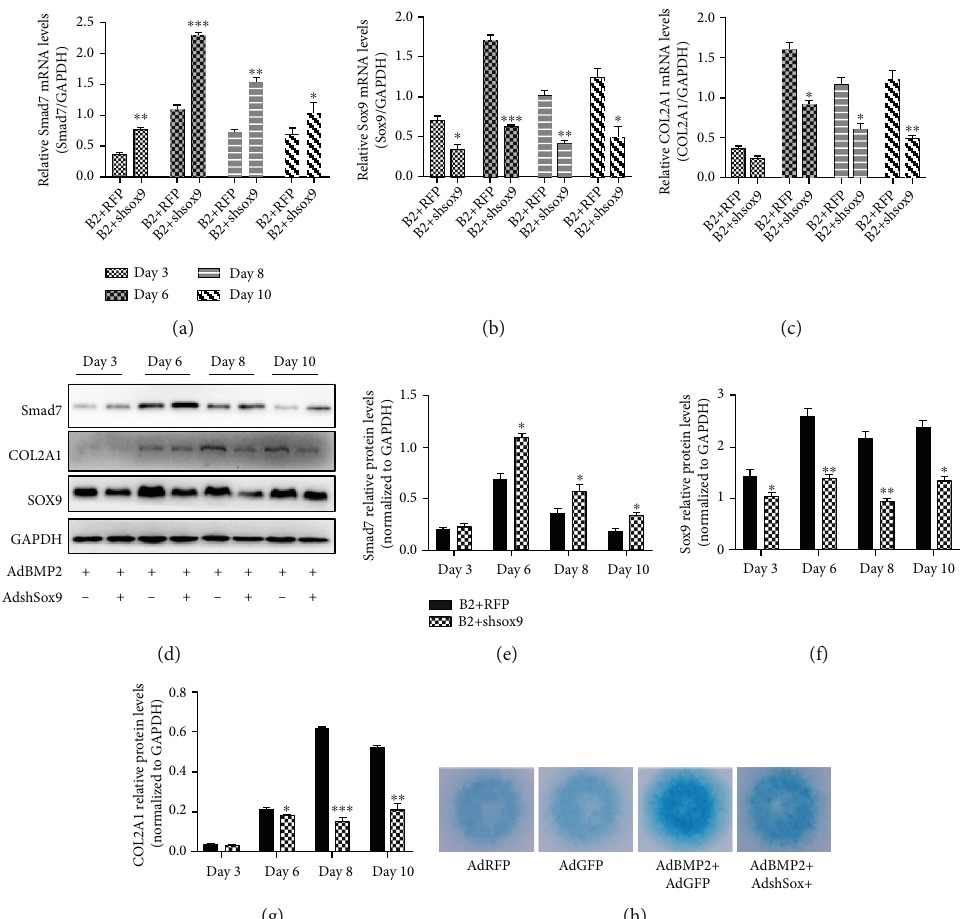
Figure 1: Silencing Sox9 inhibited BMP2-induced chondrogenesis. (a – c) Gene expression detected by qPCR revealed that silencing Sox9 inhibited BMP2-induced expression of Sox9 and COL2A1, while it promoted that of Smad7. (d – g) WB mimicked the results of qPCR. (h) Alcian Blue staining of micromasses demonstrated weakened chondrogenic capacity of shSox9-treated MSCs. ∗ p < 0 : 05 , ∗∗ p < 0 : 01 , and ∗∗∗ p < 0 : 001 , comparison with group AdBMP2 at corresponding time points. B2: